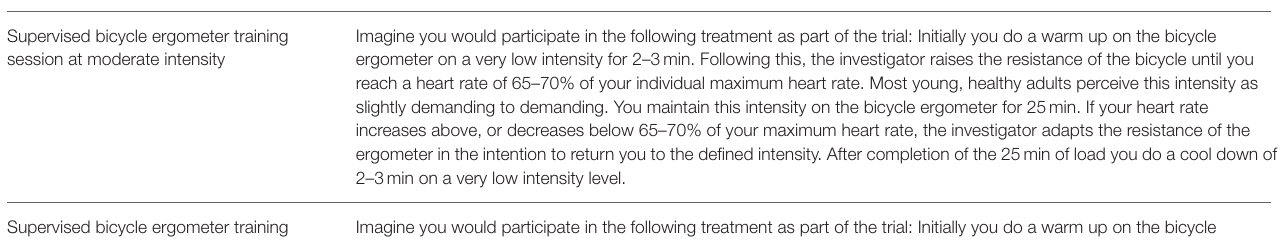
TABLE 1 | Treatment and cognitive task descriptions that participants read. Intervention Description provided to participants Supervised bicycle ergometer training session at moderate